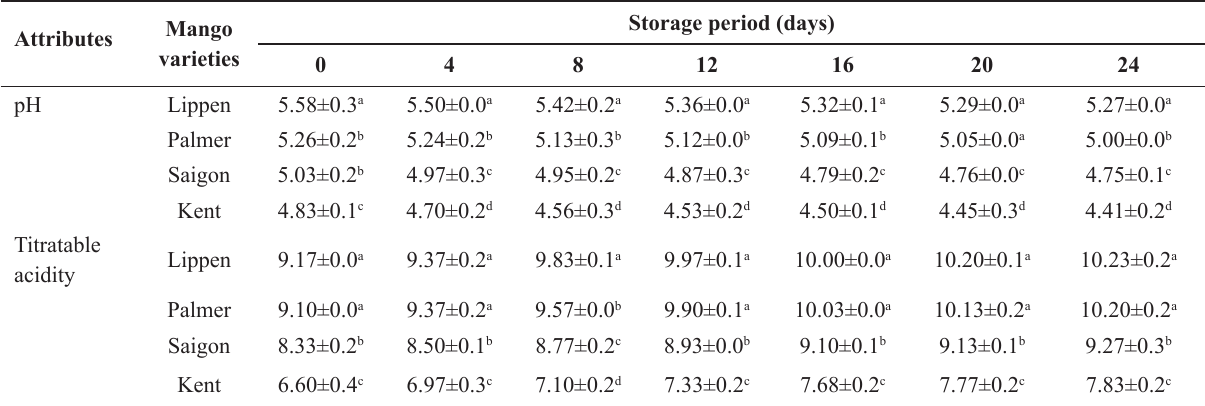
Table 1: pH and titratable acidity (mg/100 g) contents of juice produced from four mango varieties during storage. Mango Attributes